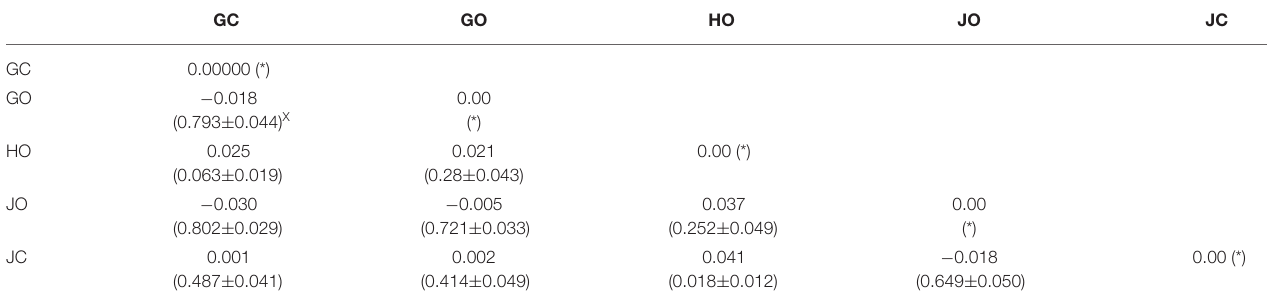
TABLE 8 | Population pairwise (F ST ) difference based on the distance method. GC HO